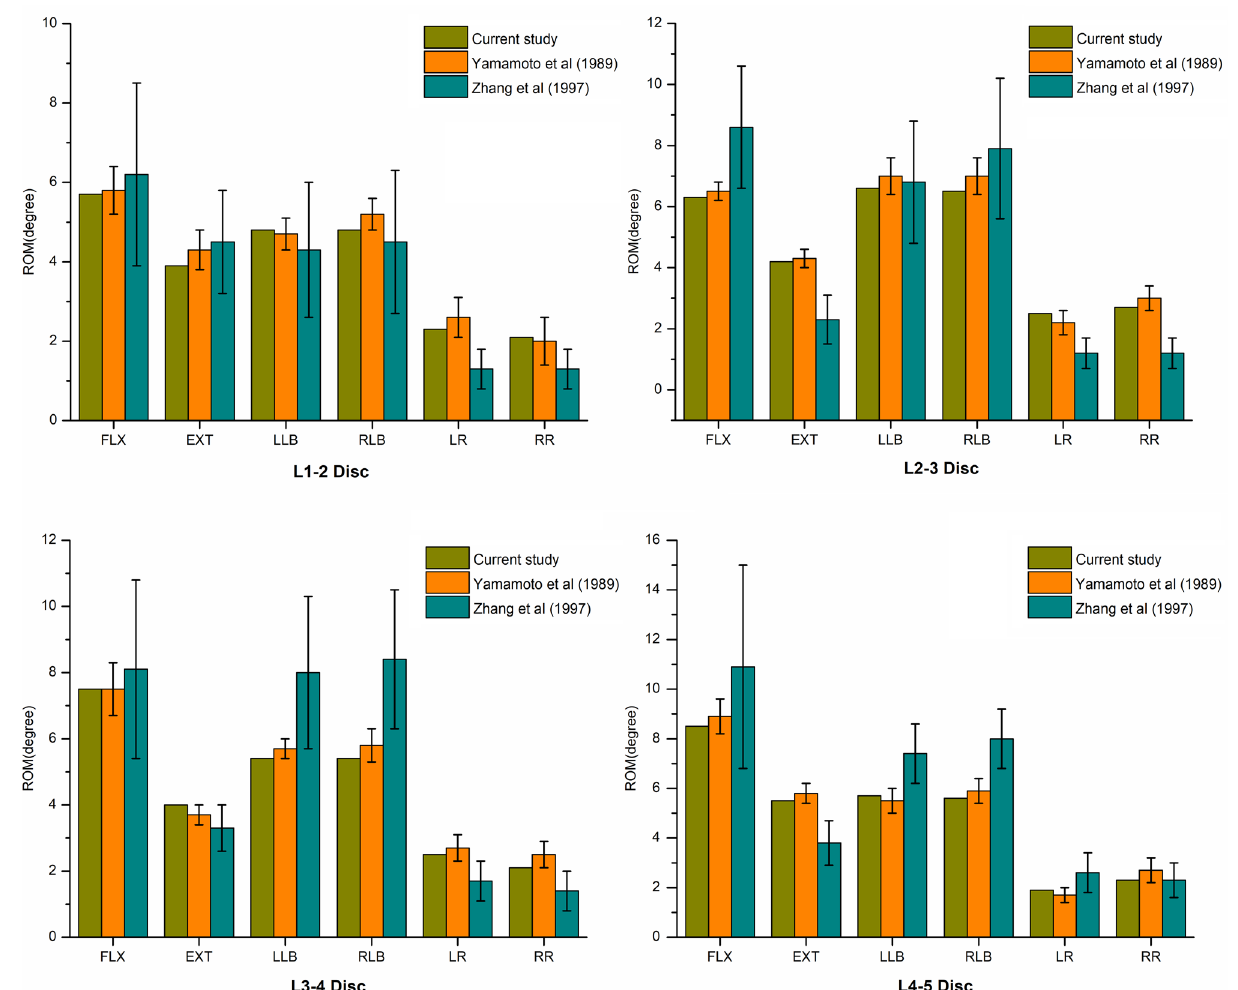
Figure 1. Comparison of ROMs between the current intact FE model and the outcomes of previous